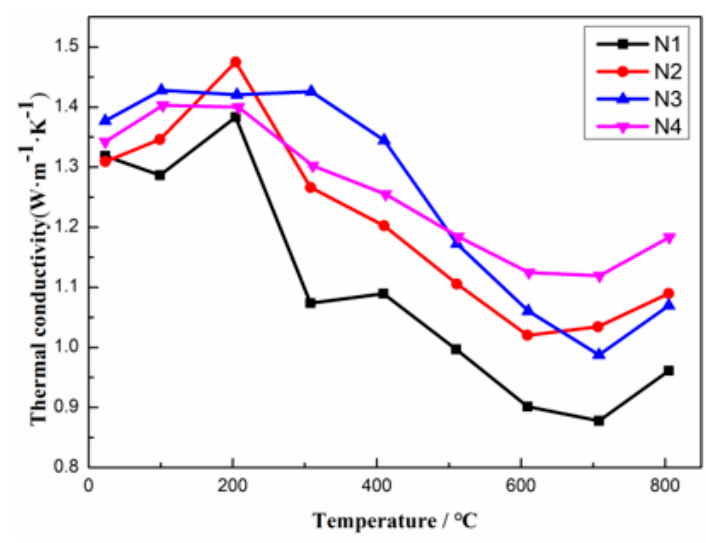
Figure 4. Thermal conductivities of N1, N2, N3 and N4.